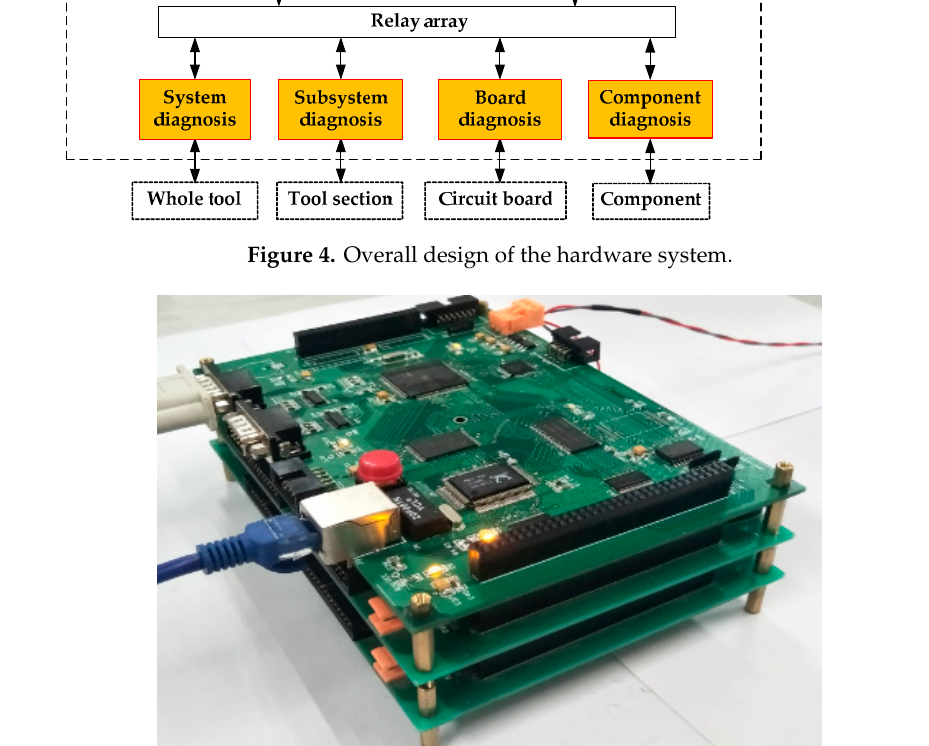
Figure 5. Structure of building-block stacking for the system.